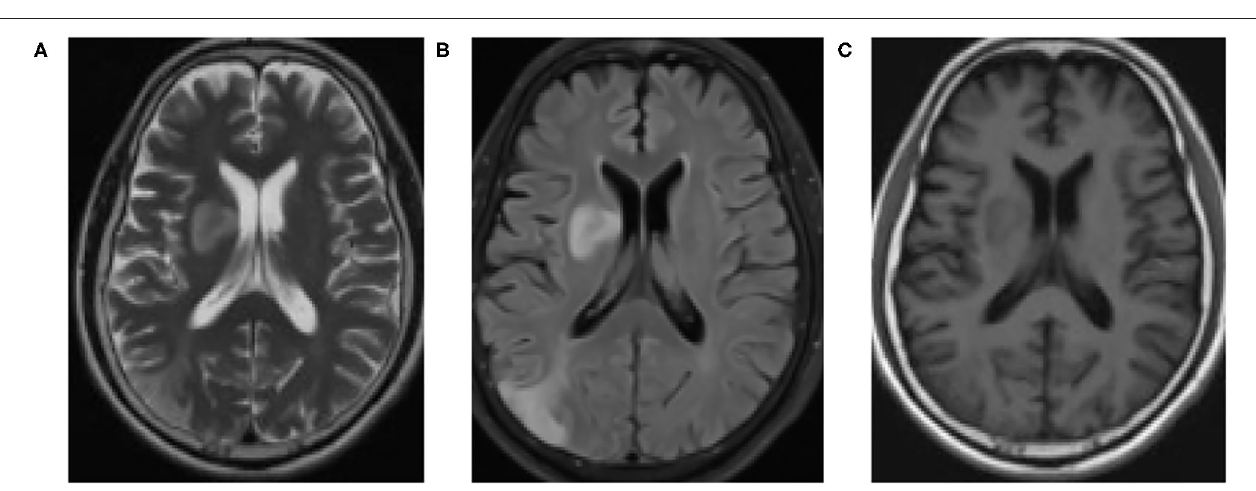
FIGURE 6 | MRI examination results. (A) before drug treatment; (B) during drug treatment; (C) one week after drug discontinuation.